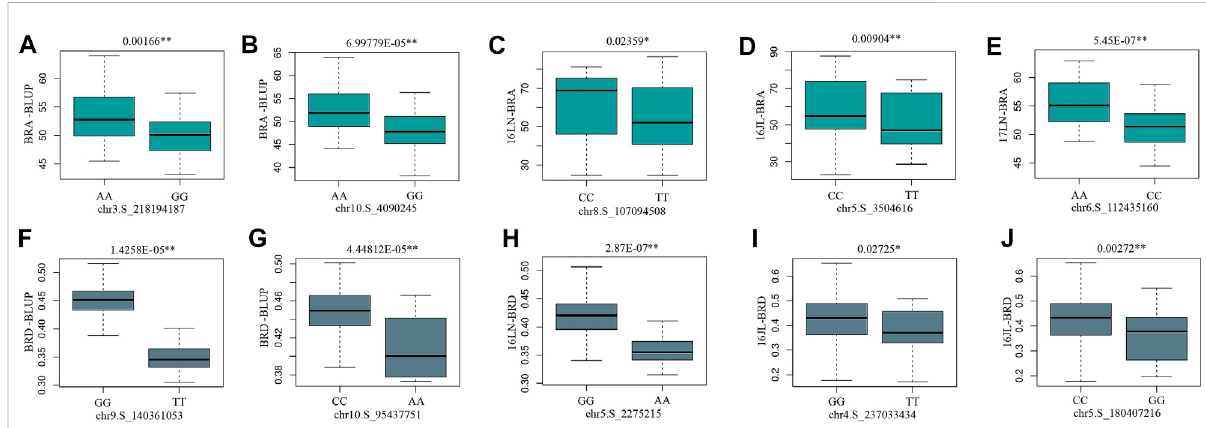
FIGURE 7 The boxplot of phenotypic differences between the major and minor alleles of signi fi cant SNPs associated with BRA and BRD. The p -values (Student ’ s t -test)ofthealleliceffectsofBRAandBRDareexhibitedaboveeachsmallplot. (A) BRA-BLUP , (B) BRA-BLUP , (C) 16LN-BRA , (D) 16JL-BRA ,